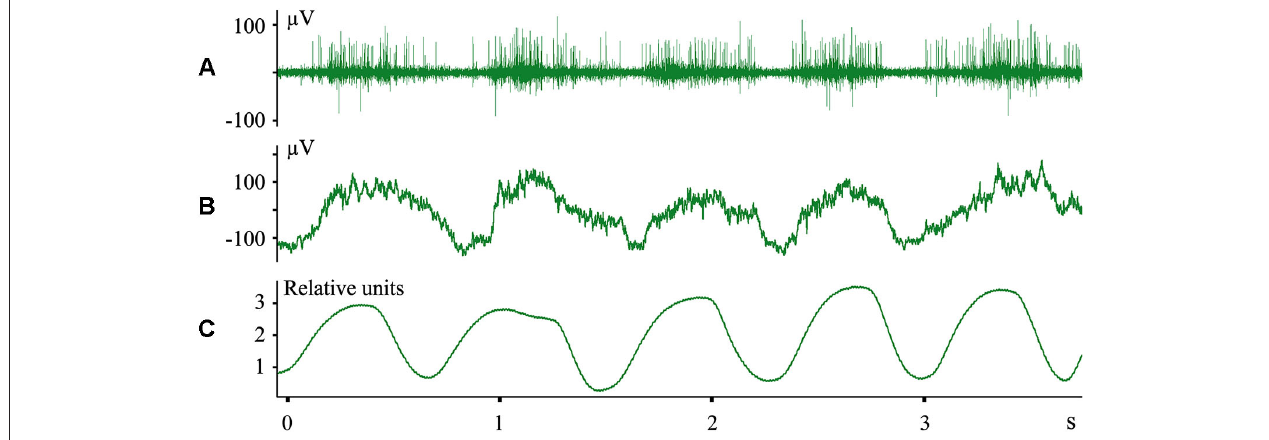
FIGURE 6 | Neuronal activity in the cat primary visual cortex synchronized with respiration during SWS. (A) Multiunit activity; (B) local field potentials (local EEG); (C) nasal air flow in relative units. Technical details of the study in Pigarev et al.